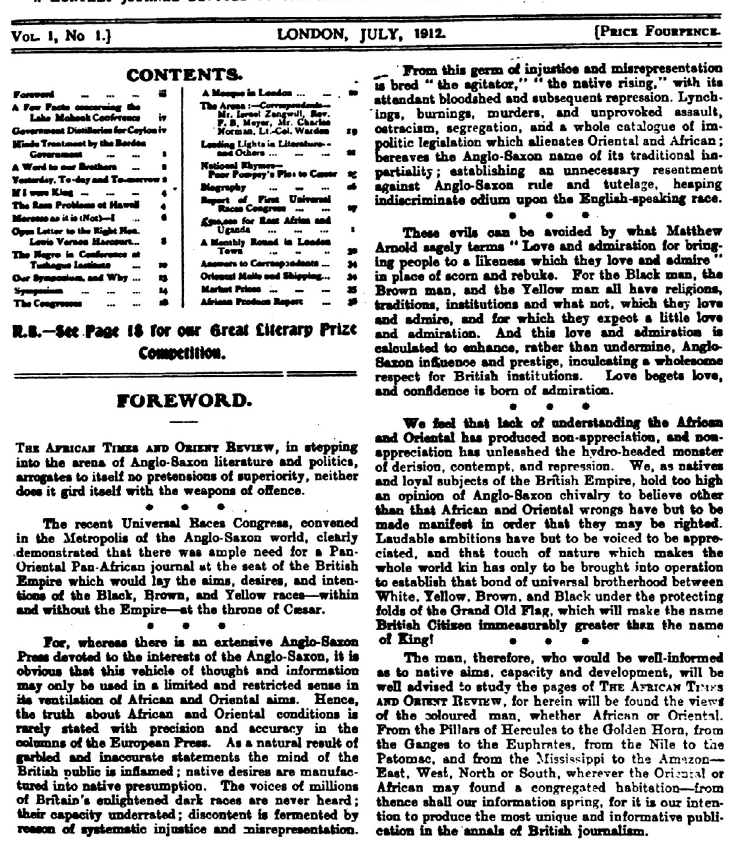
Fig. 2 Masthead of first issue, African Times and Orient Review (July